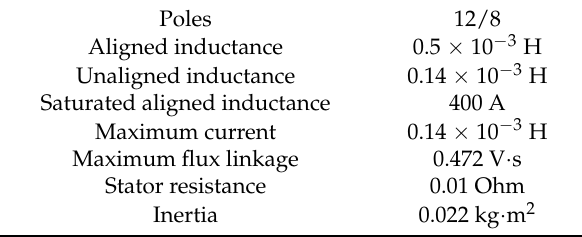
Table 3. Parameters of the switched reluctance motor (SRM) in the